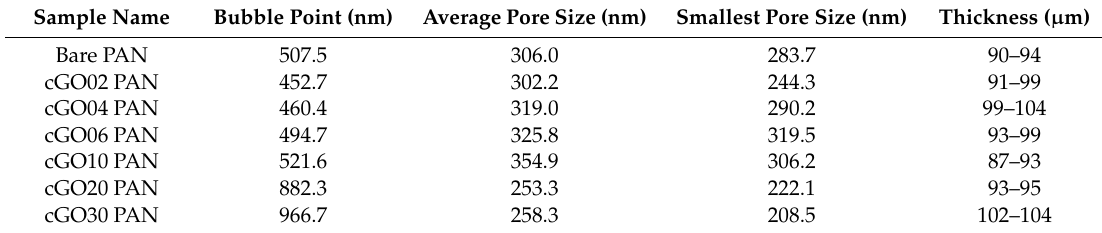
Table 1. Overall membrane properties of composite nanofiber membranes as a function of the cGO content.